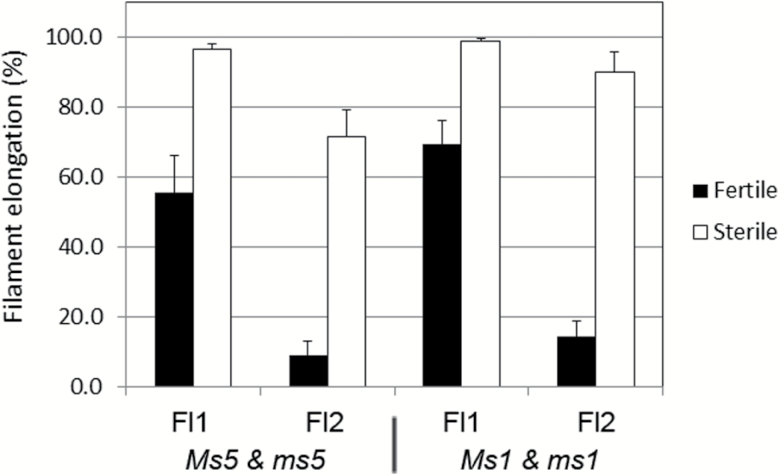
Timing of filament elongation in male-fertile and male-sterile plants. Primary (Fl1) and secondary (Fl2) florets of eight middle spikelets were opened during the late morning of 3 DF and were checked for filament elongation. The percentage of florets containing one or more elongated filaments in male-fertile and male-sterile plants is indicated on the y-axis. Two independent male-sterile mutant lines (ms5 and ms1) were used for this experiment. There are significant differences (t-test, P-value <0.01) between fertile and sterile samples in all combinations. Error bars=SE.